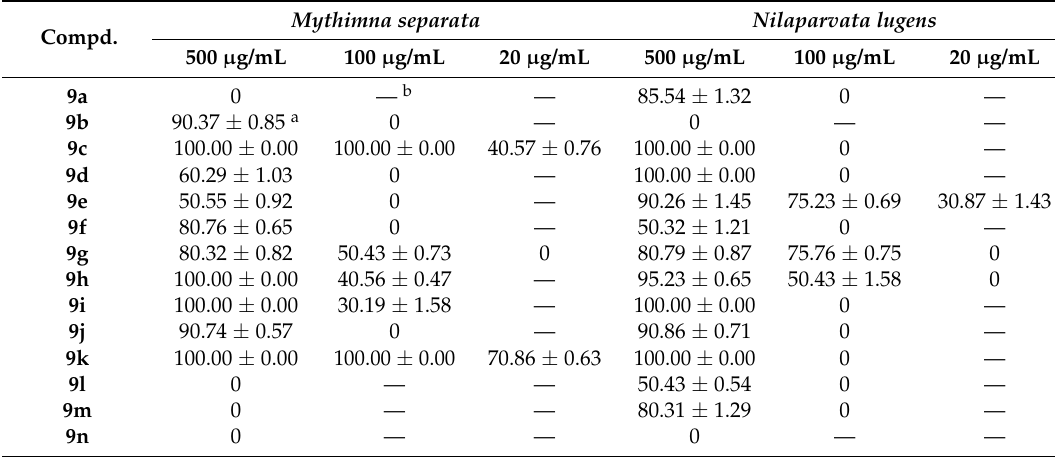
Table 2. Insecticidal activities of title compounds 9a – 9v and 13a – 13f (mortality, %).